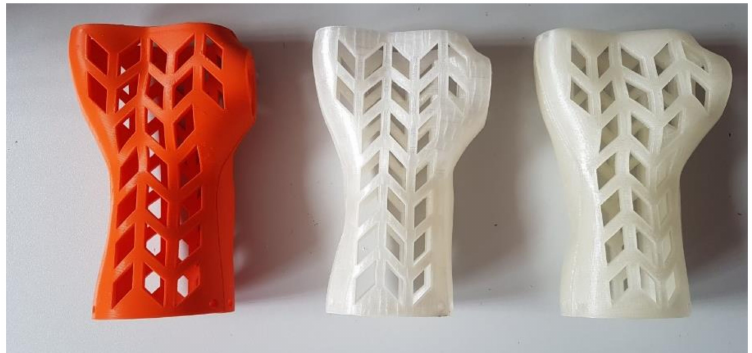
Figure 9. Orthoses manufactured vertically from PLA, strategies. ( left to right ) Econo, accura,